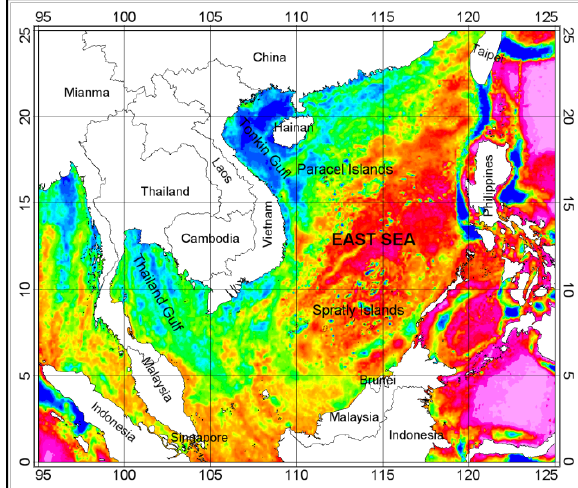
Figure 6. Showing the continental, transitional and oceanic crust and sedimentary basins (from satellite-derived isostatic residual gravity